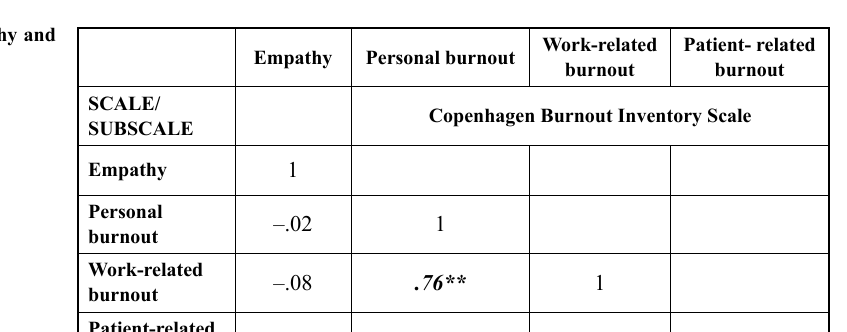
Table 8. Correlation matrix of Empathy and Professional